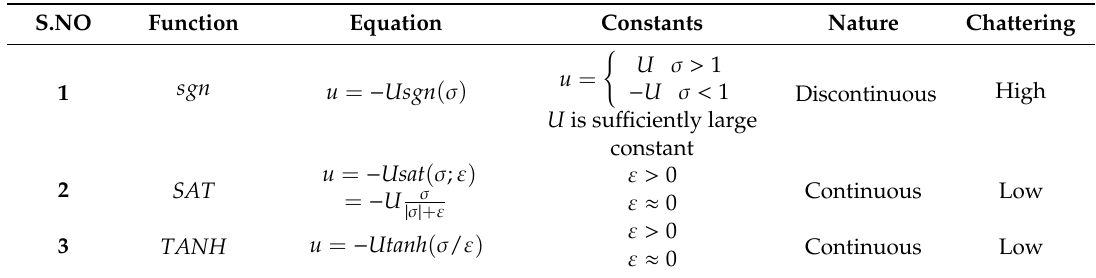
Table 2. Comparison of various first-order SMC